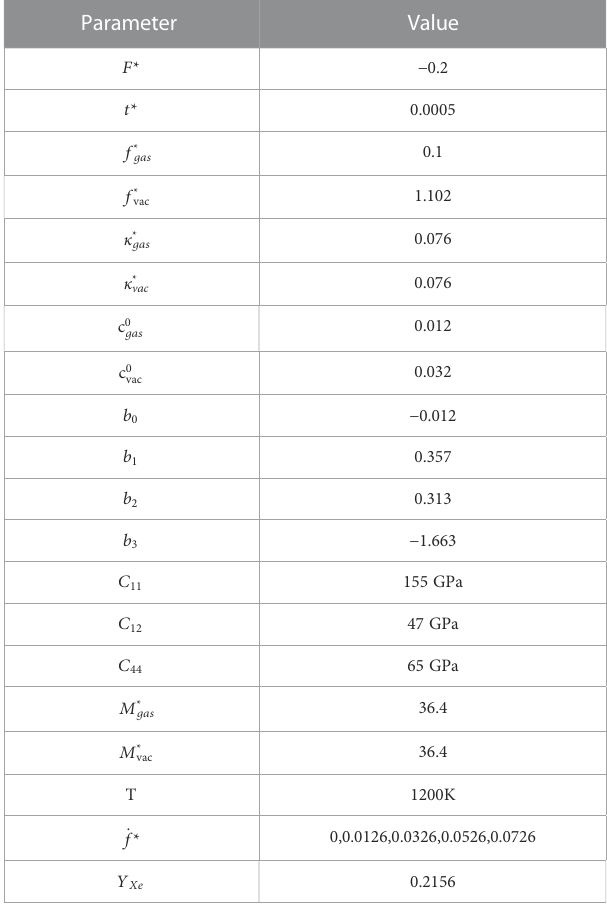
TABLE 1 Parameters used for phase- fi eld